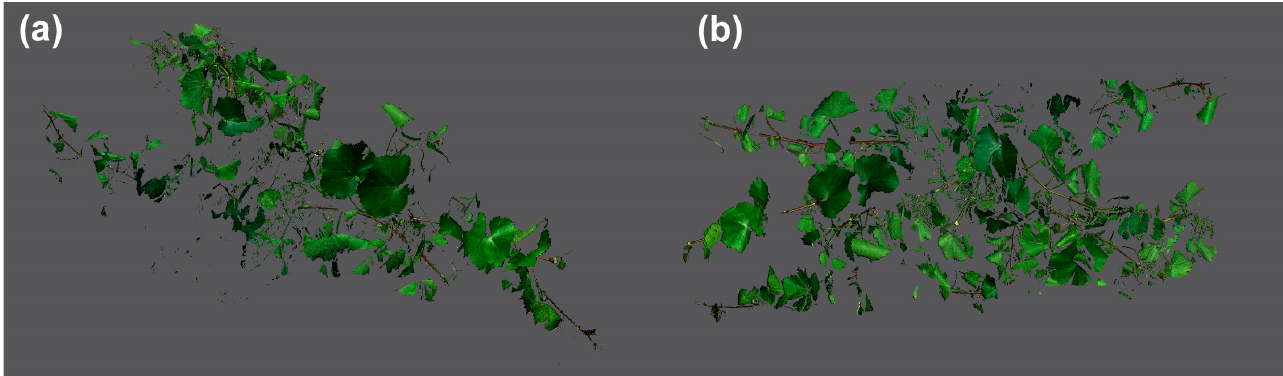
Figure 2. Exemplary display (3D model) of the representative vine (obtained with PlantEye F500 multispectral 3D scanner (Phenospex, Heerlen, The Netherlands)) at the SUPREHILL CZO at assumed maximum Leaf Area Index (LAI); ( a ) side view; ( b ) top view.